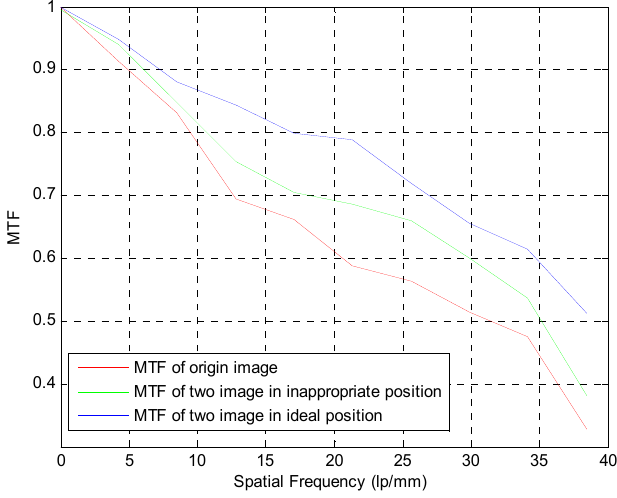
Figure 15. MTF comparison of the experimental results.